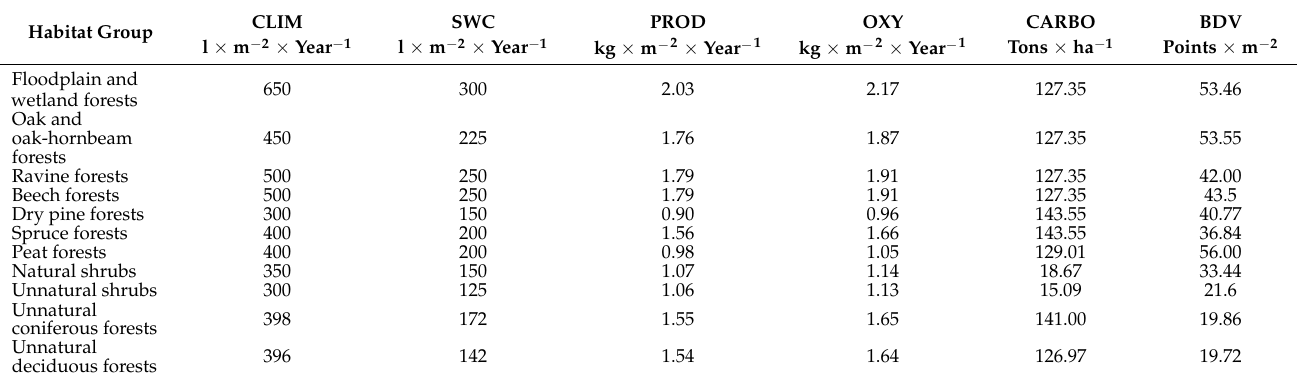
Table 3. Average values for provision of ecosystem